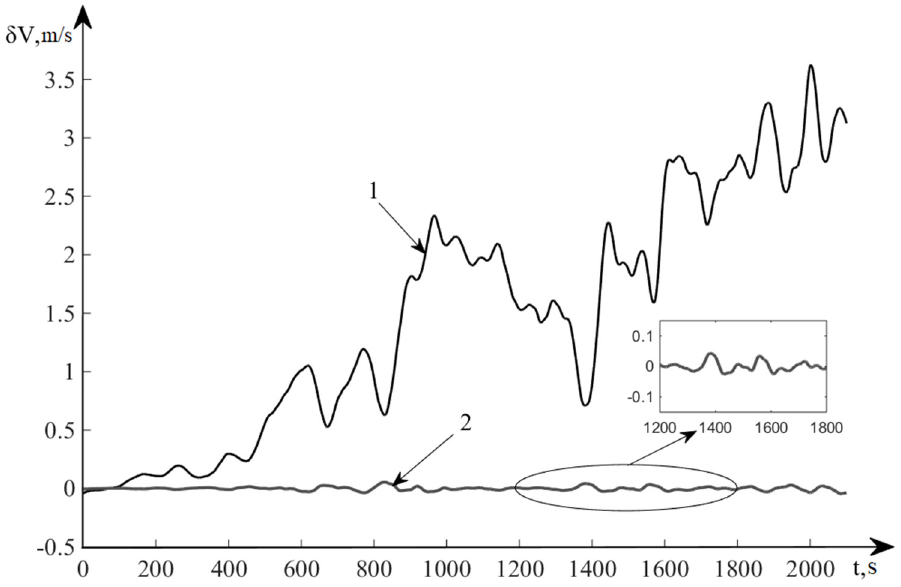
Figure 7. TS060K Errors for determination of velocity.